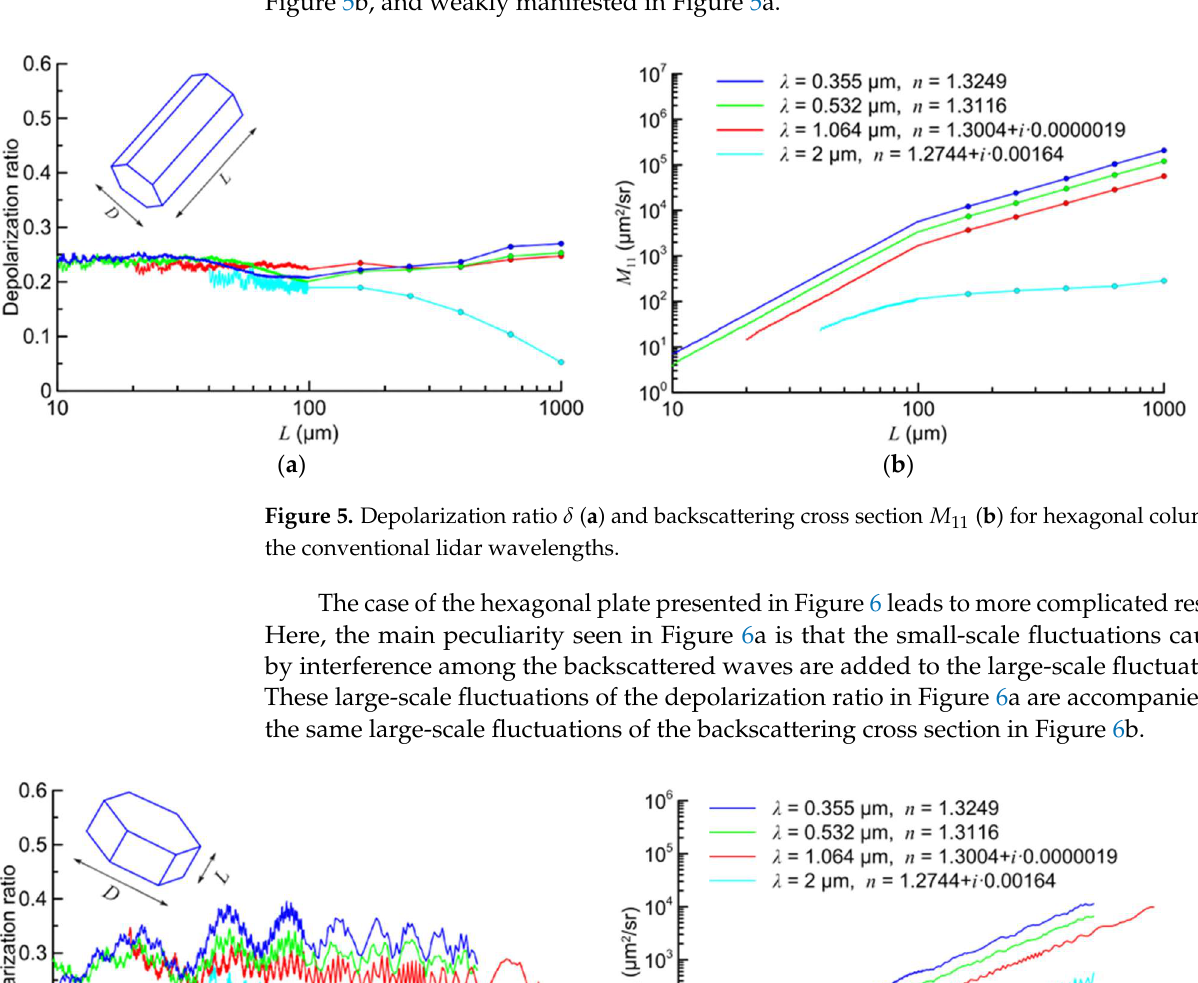
Figure 6. Depolarization ratio δ ( a ) and backscattering cross section M 11 ( b ) for hexagonal plate at the conventional lidar wavelengths.